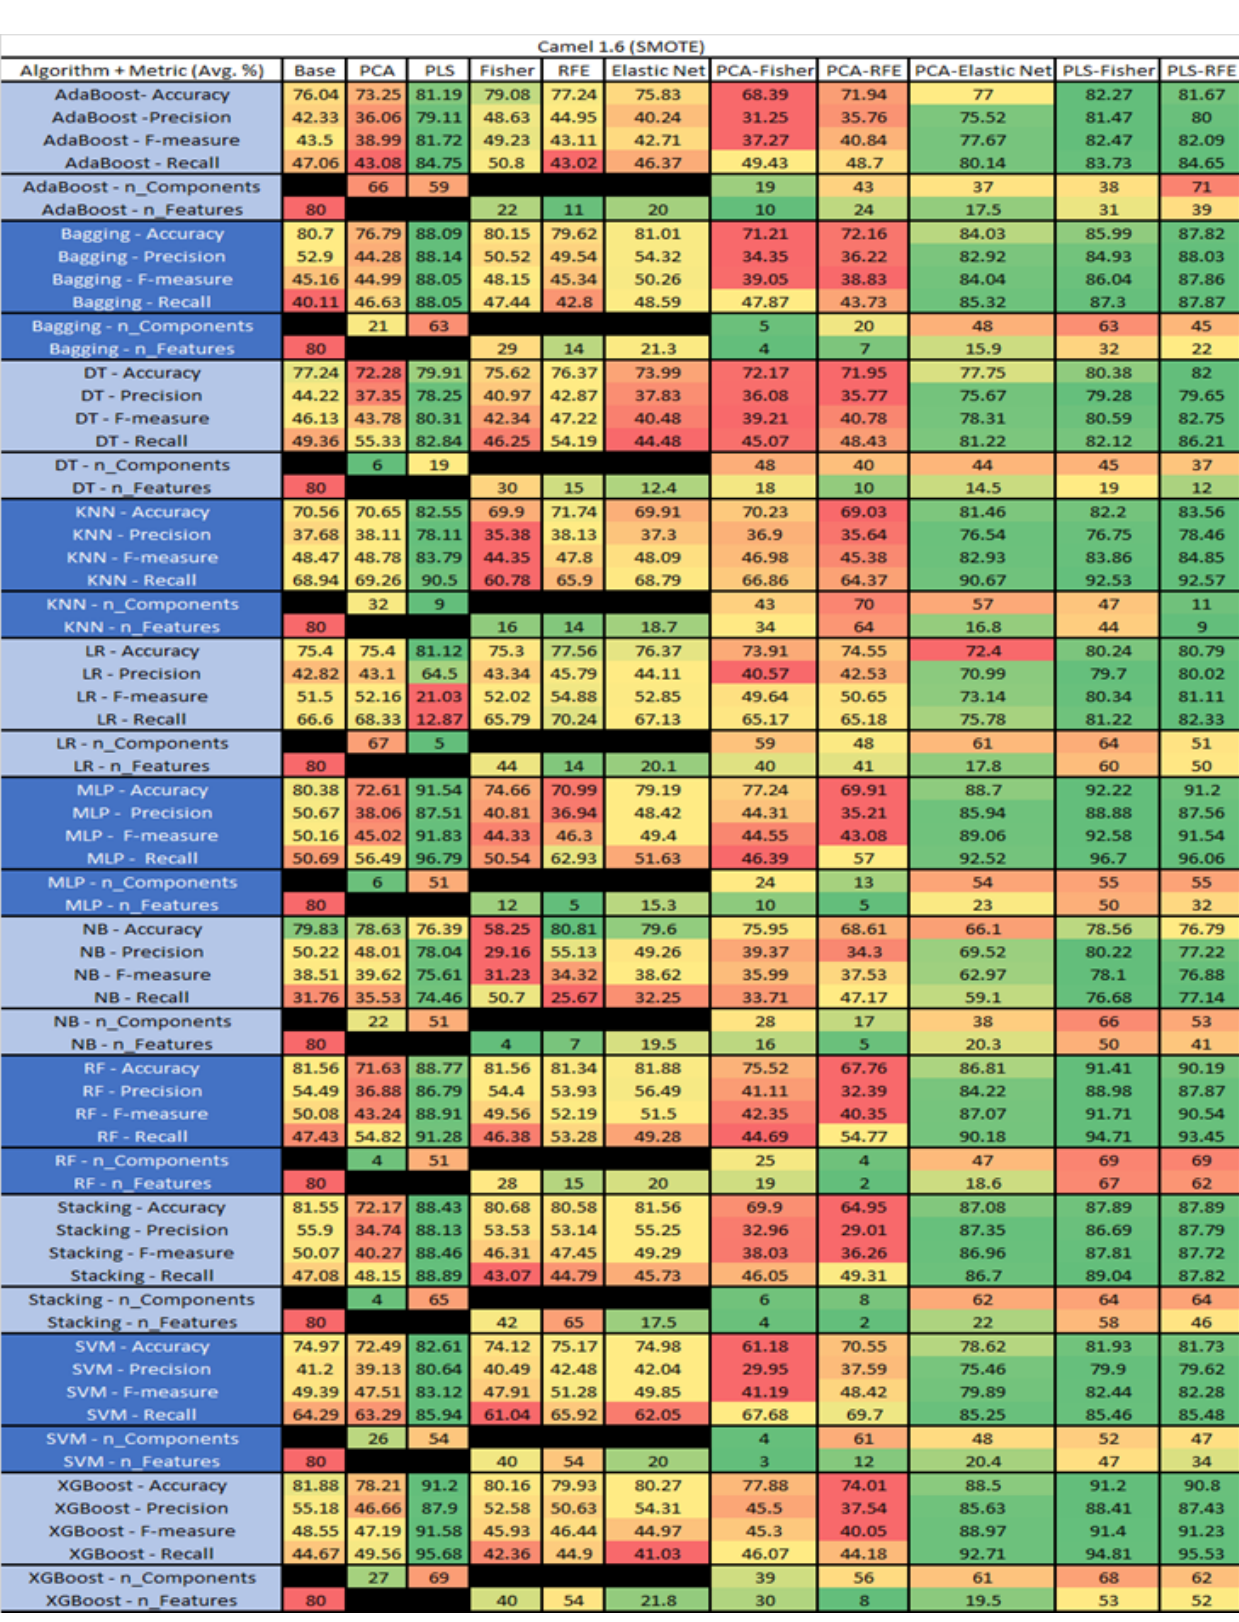
Figure 17. Camel 1.6 with SMOTE PROMISE Results Data